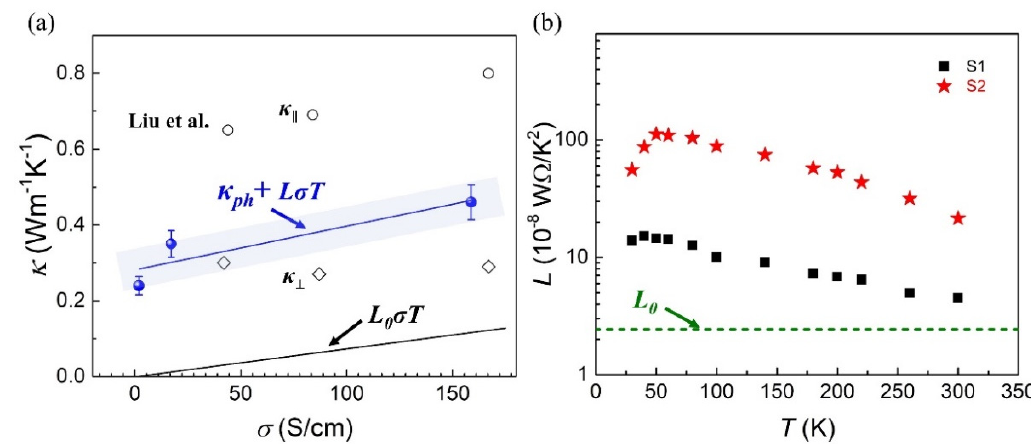
Figure 4. ( a ) the axial thermal conductivities of the S1, S2, and S3 nanofibers increase as the electrical conductivity changes by two orders of magnitude at 300 K. Blank circles and diamonds represent the in-plane thermal conductivity ( κ ∥ ) and the cross-plane thermal conductivity ( κ ⊥ ) of the PEDOT:PSS film [16]; ( b ) the calculated Lorentz number L of S1 and S2 in the whole measured temperature range. The olive-green dotted line represents the Sommerfeld value L 0 .